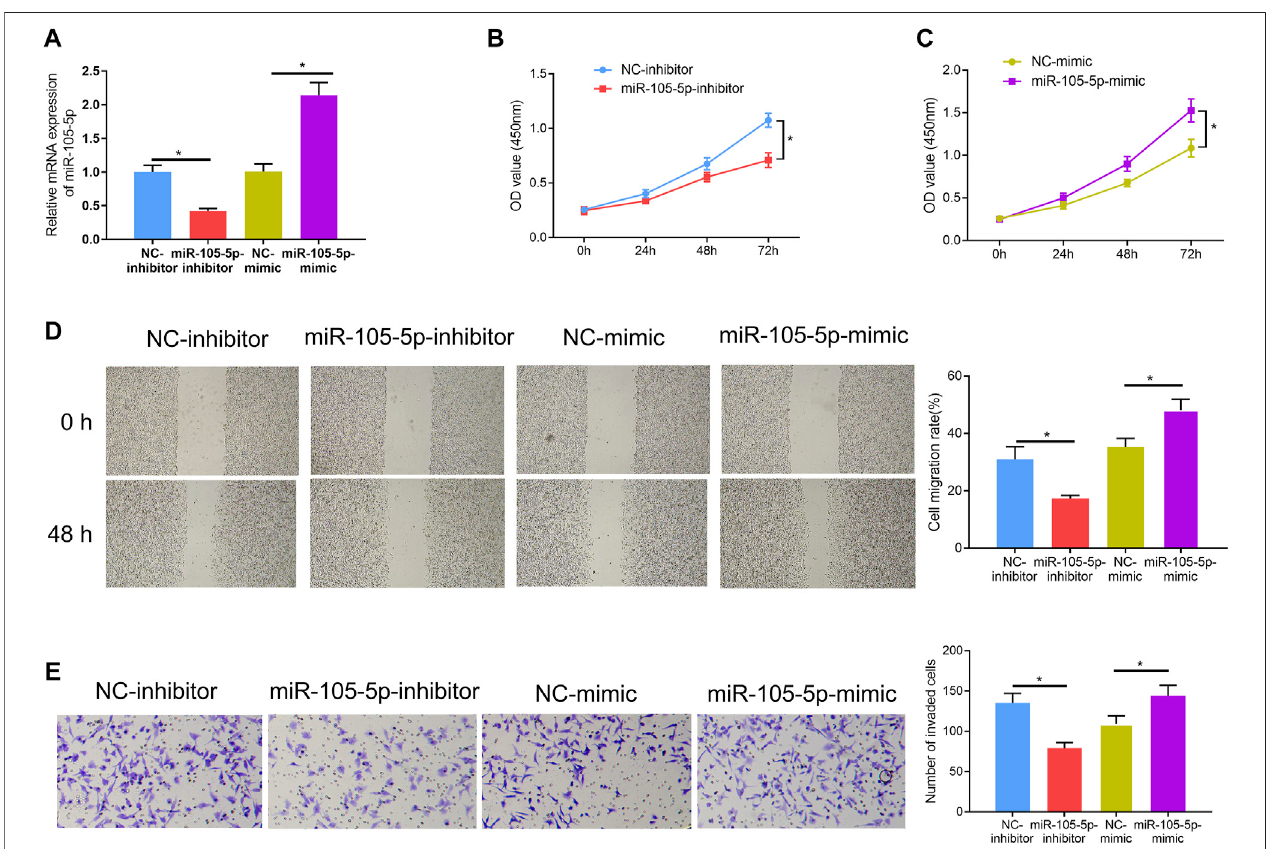
FIGURE2| MiRNA-105-5pfostersESCCcellprogression. (A) Theef fi ciencyofsilencingoroverexpressingmiRNA-105-5pinESCCcells; (B,C) Effectofsilencing/ overexpressing miRNA-105-5p on cell viability; (D,E) The effect of silenced/overexpressed miRNA-105-5p on cell migratory and invasive capacities of ESCC were assessed via wound healing assay (40×) (D) and Transwell invasion assay (100×) (E) , respectively; * p <